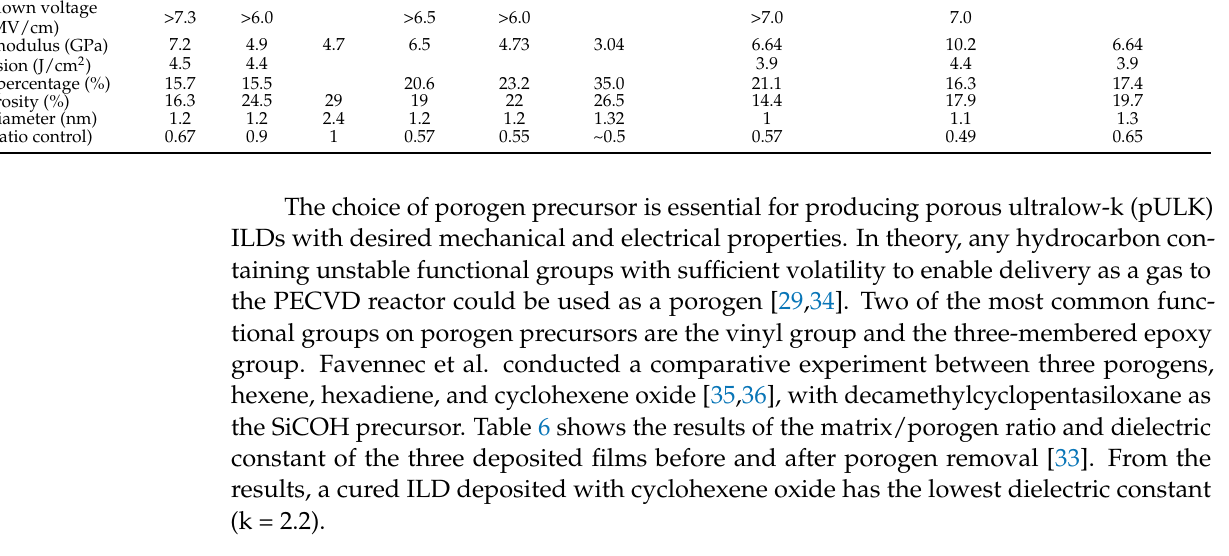
Table 6. Results of matrix/porogen ratio and dielectric constant of the three deposited films before and after porogen removal